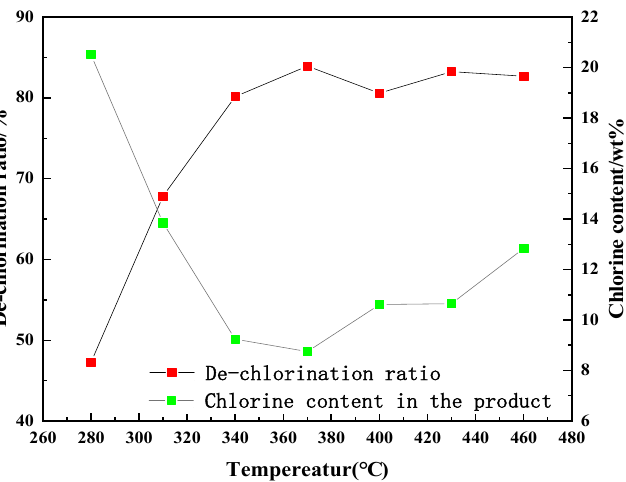
Figure 4. Chlorine content and de-chlorination ratio of PVC film at different temperatures.